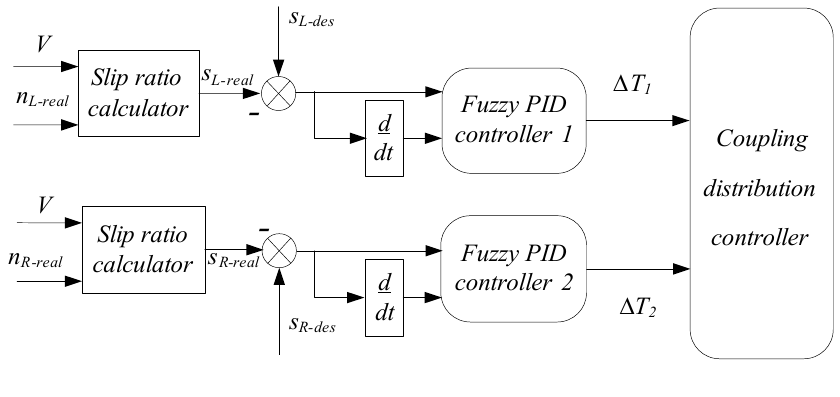
Figure 10. Slip ratio controller.